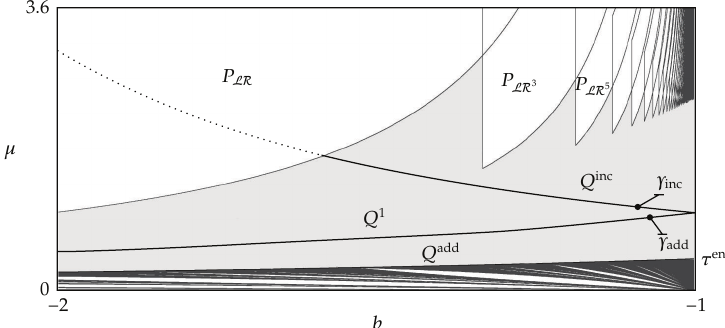
Figure 6: Numerically calculated structure of the (cid:7) b,μ (cid:8) -plane for a (cid:6) 0 . 42, b (cid:6) − 2 . 0 ··· − 1 . 0, μ (cid:6) 0 ··· 3 . 6. The two curves γ add and γ inc are analytically calculated and show the band-merging crisis curves structuring the chaotic domain. In the periodic domain, the curve γ inc is shown